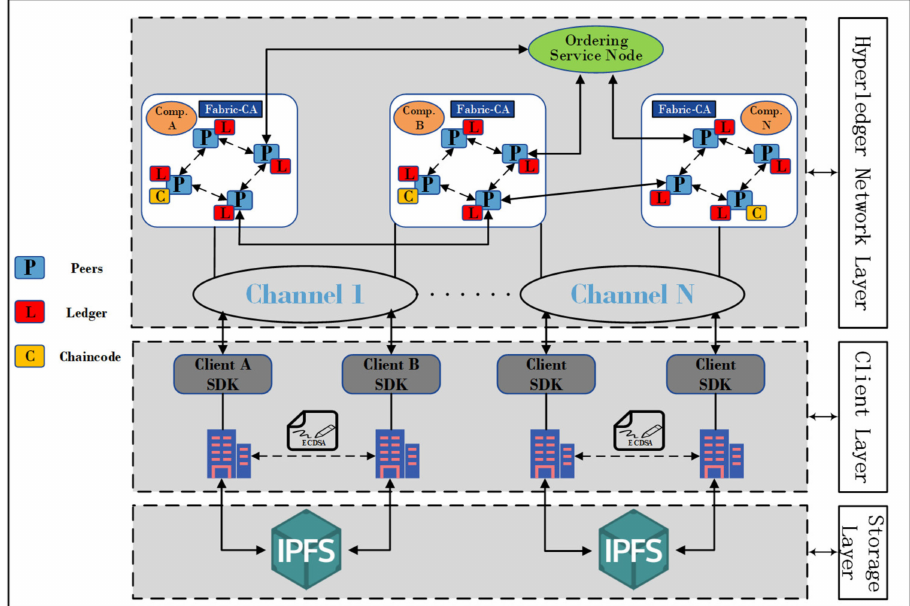
Figure 2. Hyperledger Fabric-based Framework for Enterprise Data Sharing and Privacy